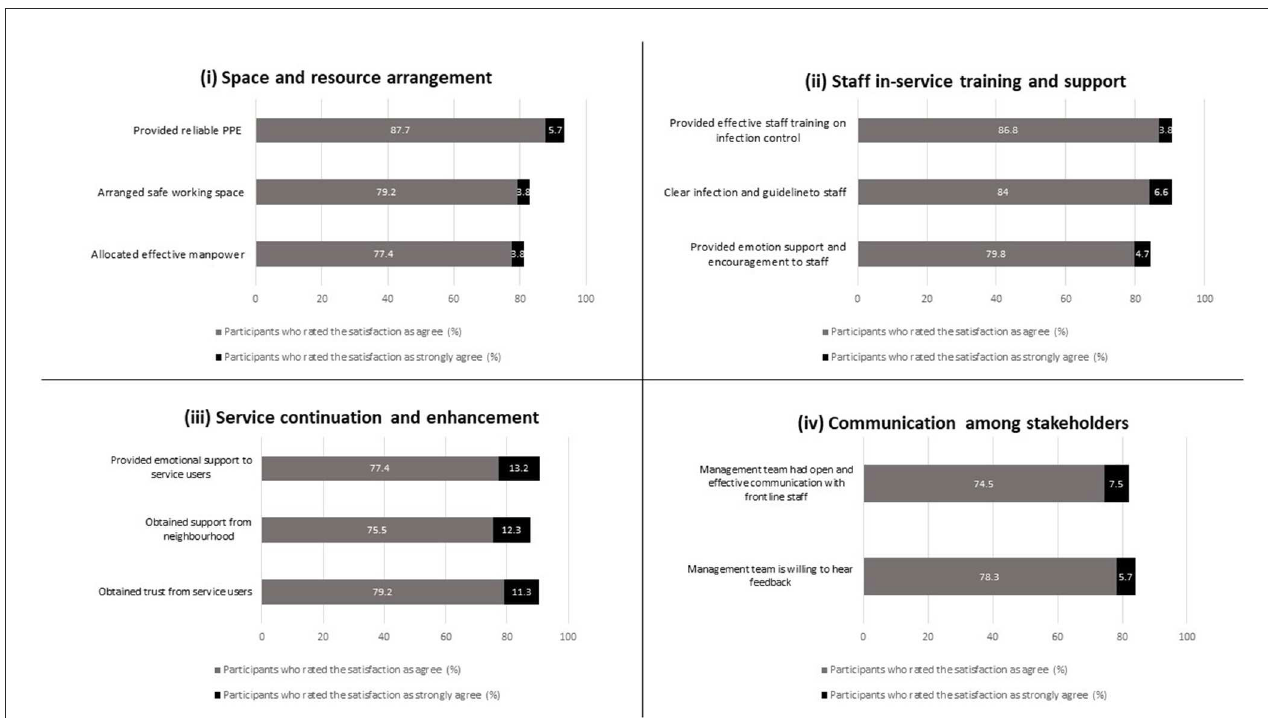
FIGURE2 Feedback from survey participants on four areas of institutional risk management amidst the COVID-19